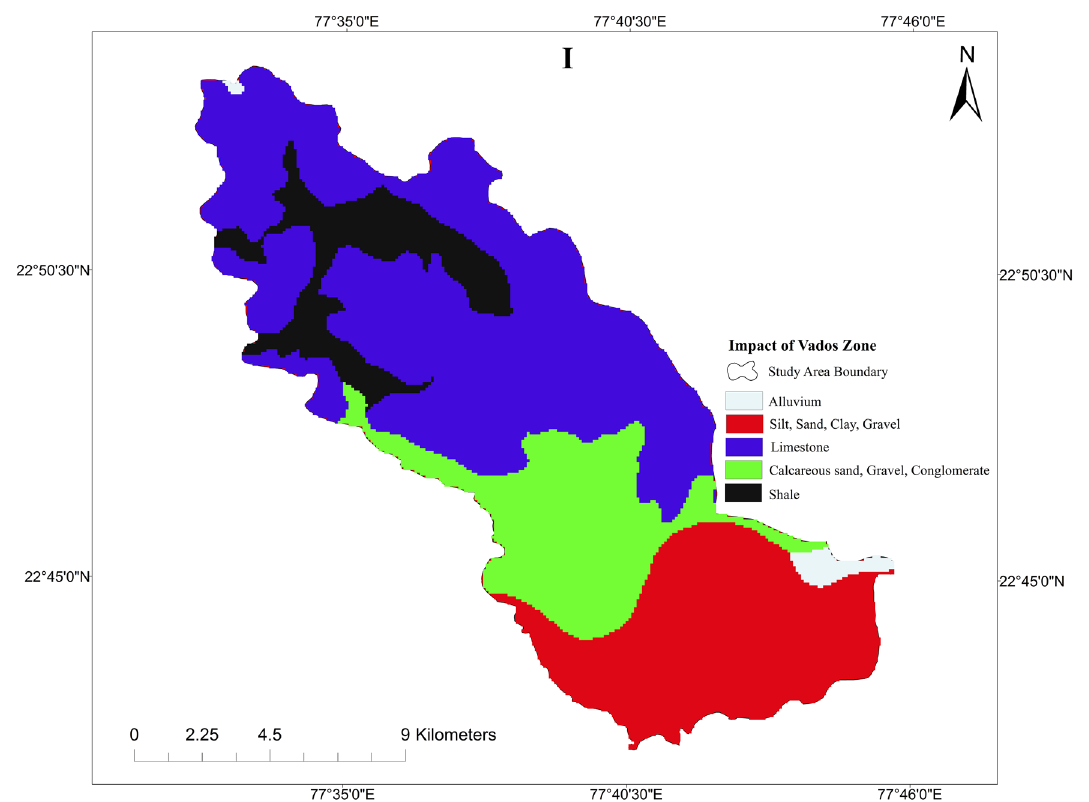
Fig. 8 Impact of vadose